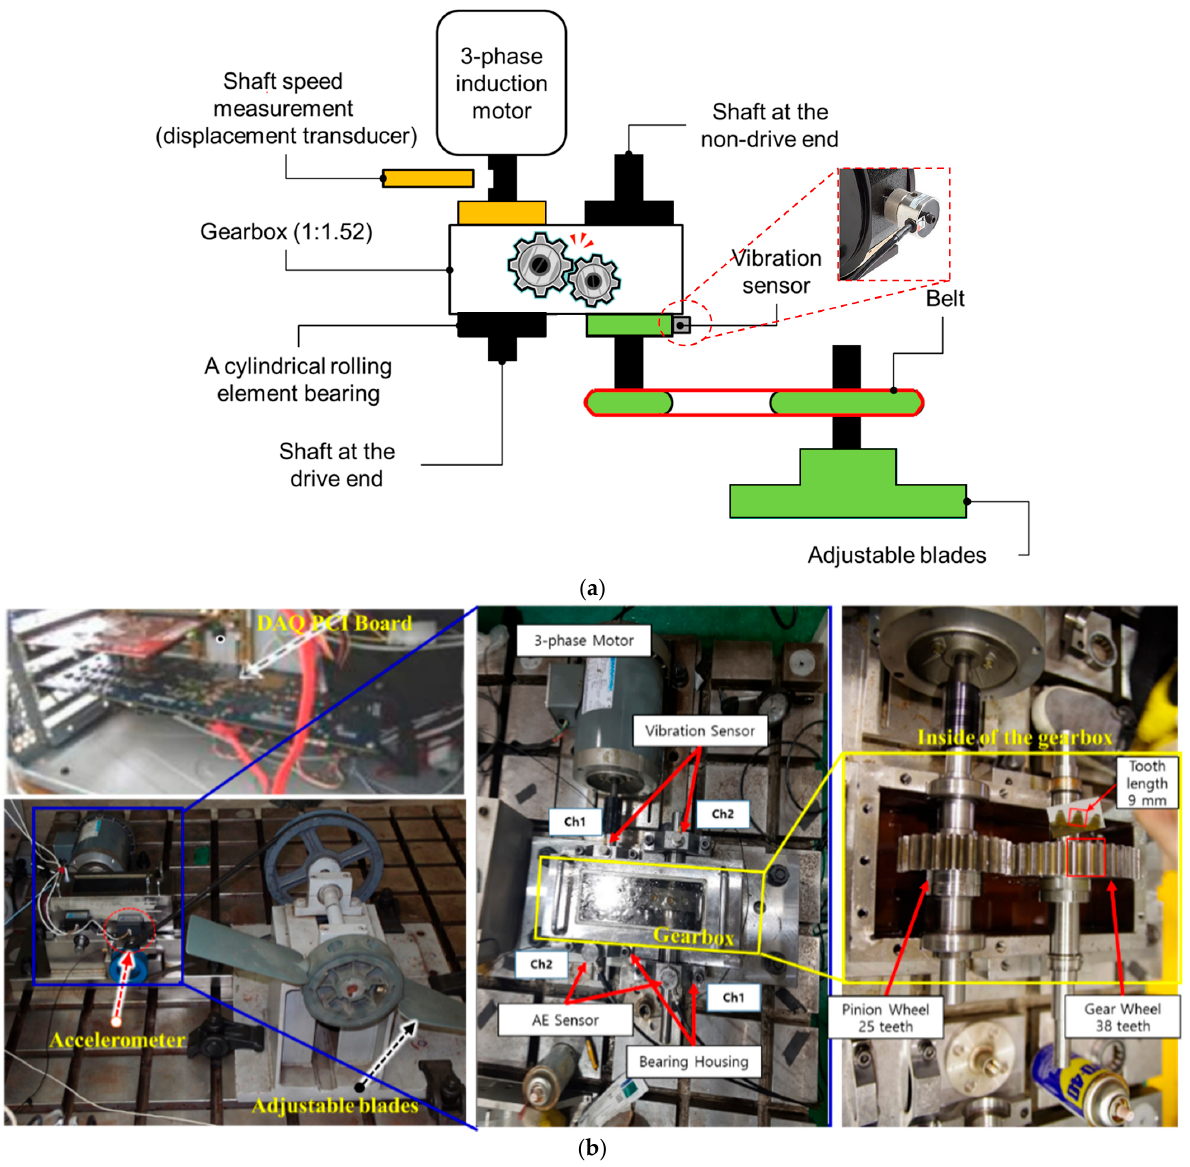
Figure 2. The experimental gearbox test rig: ( a ) functional structure block diagram and ( b ) actual arrangement of the test rig.